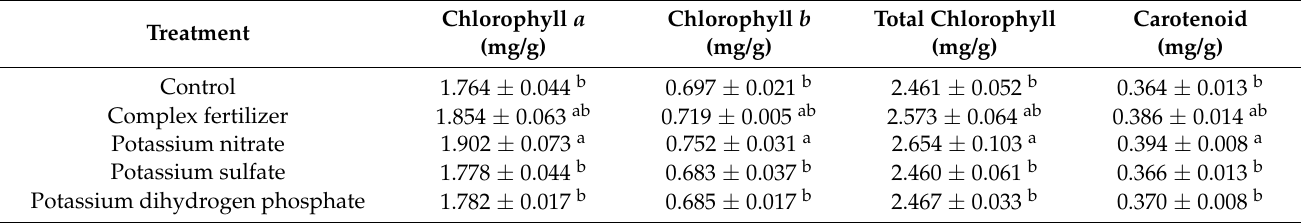
Table 1. Photosynthetic pigment content in grapevine leaves.